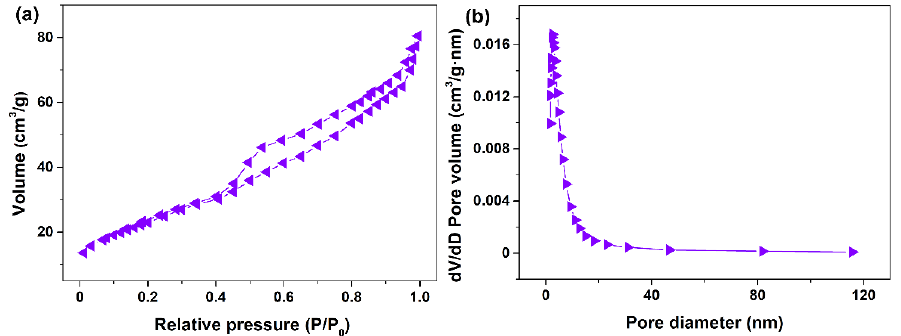
Figure 6. ( a ) N 2 adsorption–desorption isotherm and ( b ) the corresponding Barrett–Joyner–Halenda pore size distribution curve of CeO 2 hydrothermally synthesized at 200 °C for 24 h with 4 mmol guanidine carbonate and 4 mL 30% H 2 O 2 .